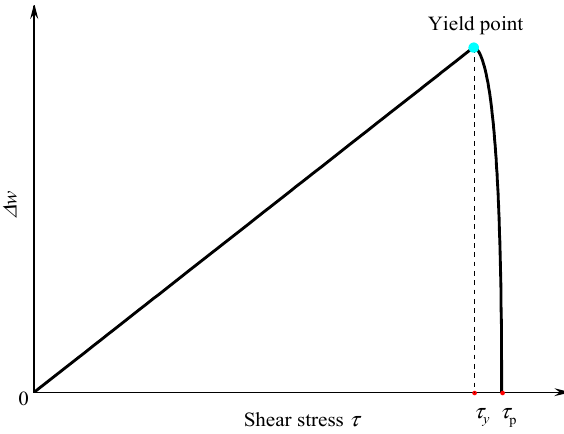
Figure 5. Δ w - τ curve under direct shear tests.